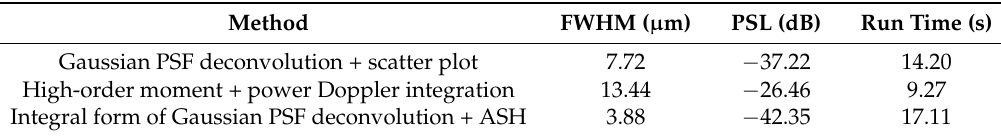
Table 1. Full-Width at Half-Maximum (FWHM), Peak Side Lobe (PSL) and the run time of different reconstruction